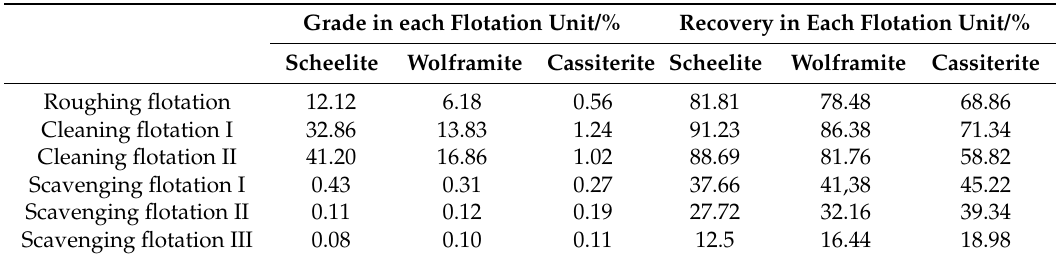
Table 3. Grade and recovery of scheelite, wolframite, and cassiterite in different flotation units.